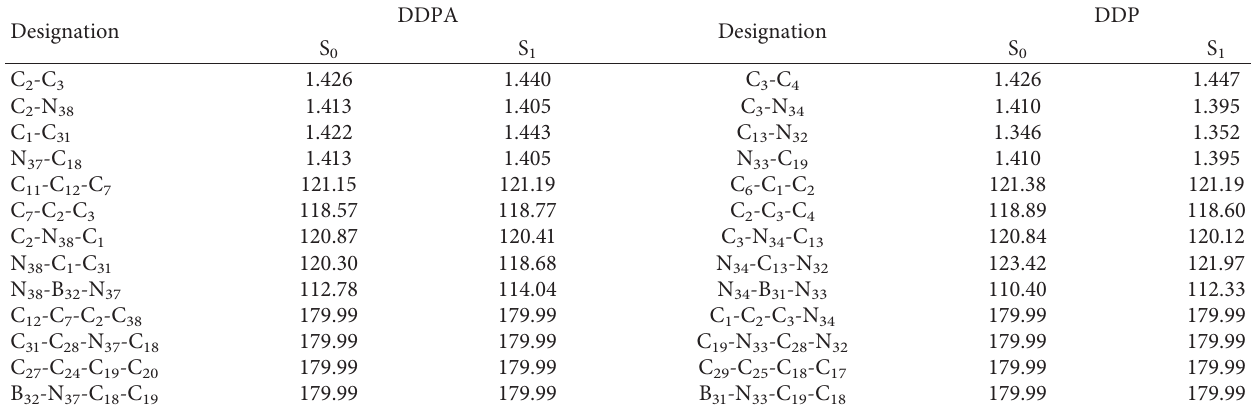
Figure 1: Optimized molecular structures for DDP and DDPA compounds in the gaseous state employing the B3LYP/6-31G (d) level of theory. Table 1: Selected optimized geometrical parameters (bond length (BL) in ˚A and bond angle (BA) and dihedral angle (DA) in degree) computed for DDP and DDPA in the gaseous state at the ground (S 0 ) and initial excited state (S 1 ) employing the B3LYP/6-31G (d) level of theory. For labeling, refer to Figure